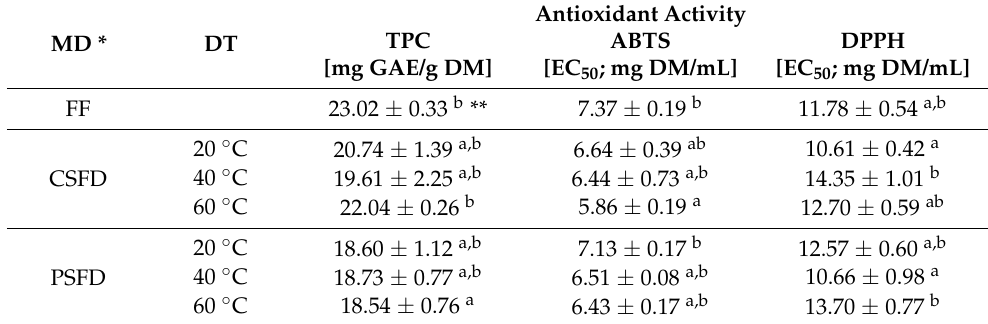
Table 7. Total phenolic content and antioxidant activity of strawberry